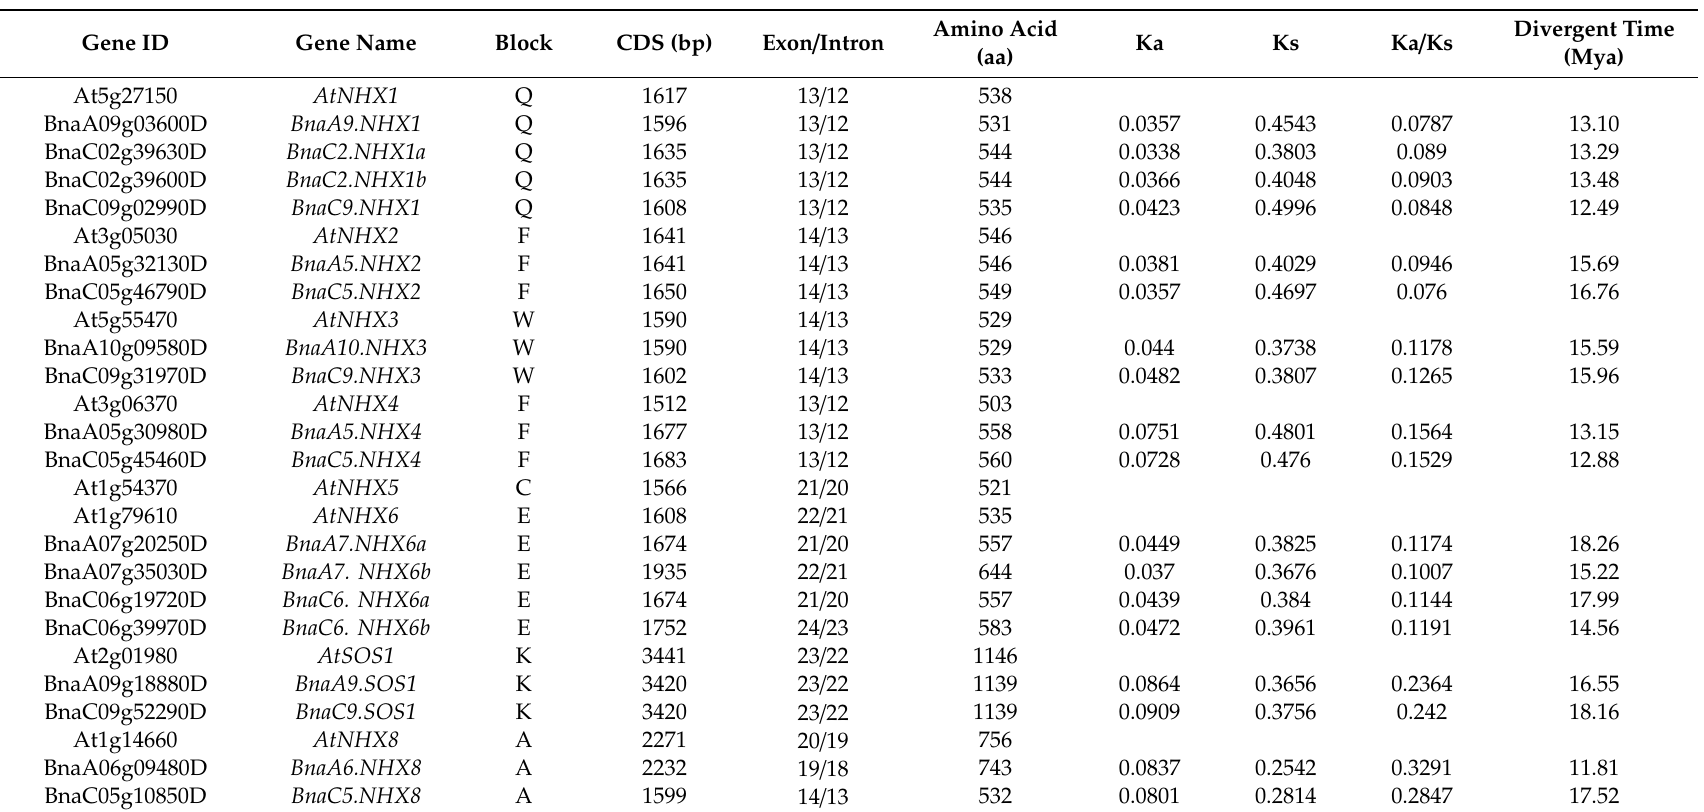
Table 2. Molecular characterization of the Na + / H + antiporters (NHXs) in Arabidopsis thaliana and Brassica